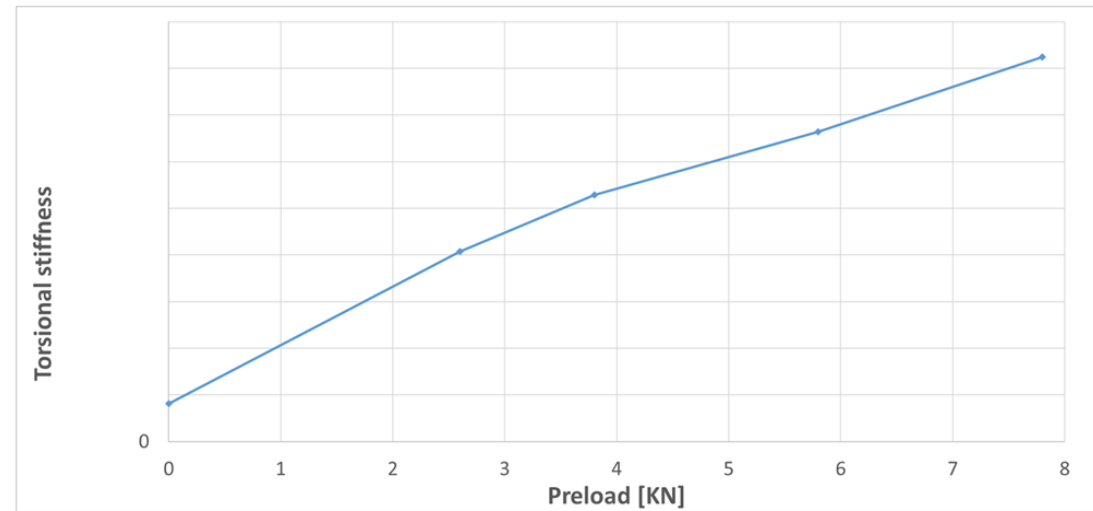
Figure 21. Experimental effect of the preload on the torsional stiffness.